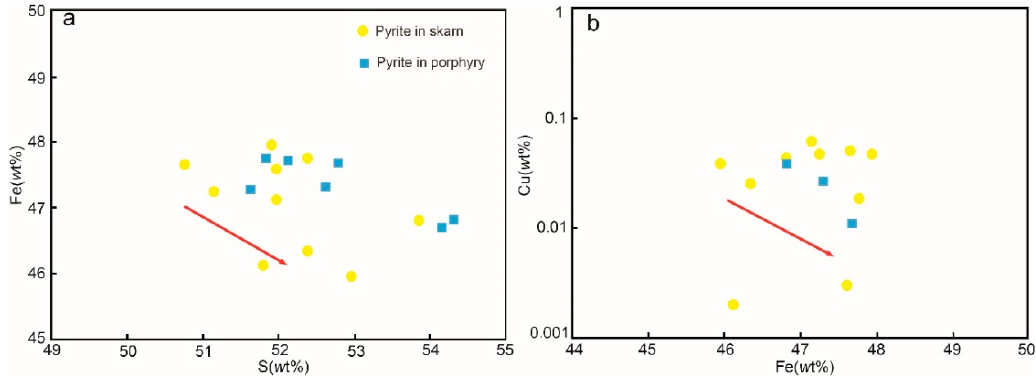
Figure 13. ( a ) Fe–S and ( b ) Cu–Fe of pyrites from the Hucunnan Cu–Mo deposit.